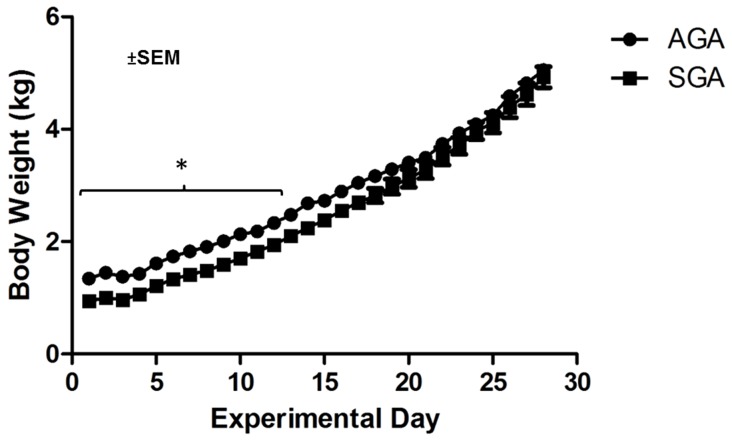
Body weight of AGA and SGA piglets during the study.Body weight of AGA and SGA piglets was different (*p<0.05) until PD14 but not thereafter. Data are shown as the mean ± SEM (n = 7).